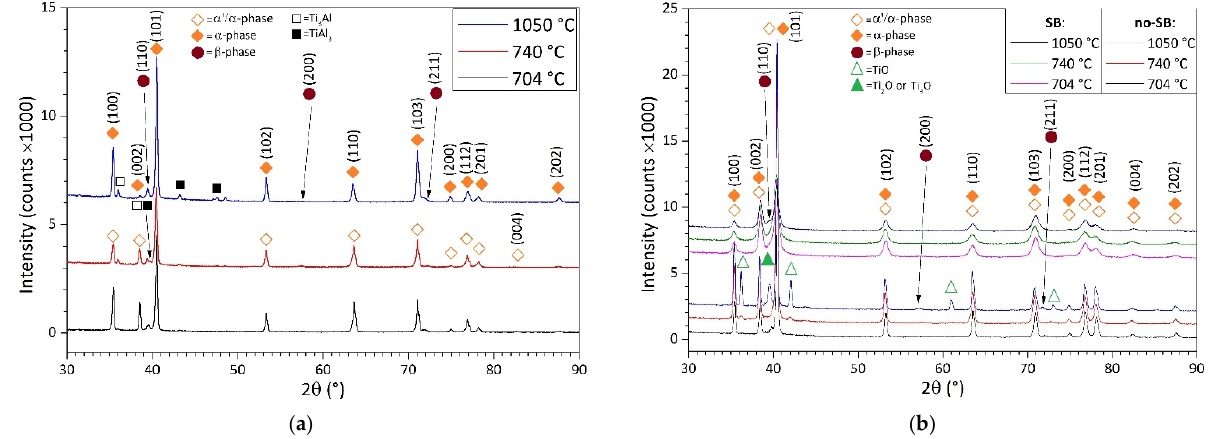
Figure 8. XRD patterns of heat-treated 90° Z -samples at 704 °C/120 ′ , 740 °C/130 ′ and 1050 °C/60 ′ per- formed on sand-blasted cross-sections ( a ), and on the external surface ( b ) before and after the sand- blasting process.